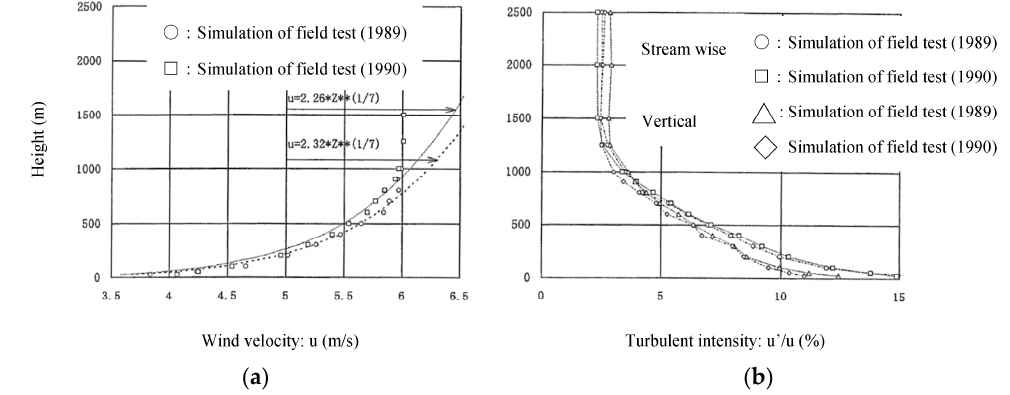
Figure 6. Vertical profiles of mean wind speed and turbulence in the wind tunnel flow ahead of the terrain model [4]. ( a ) Wind velocity ( b ) Turbulence intensity.